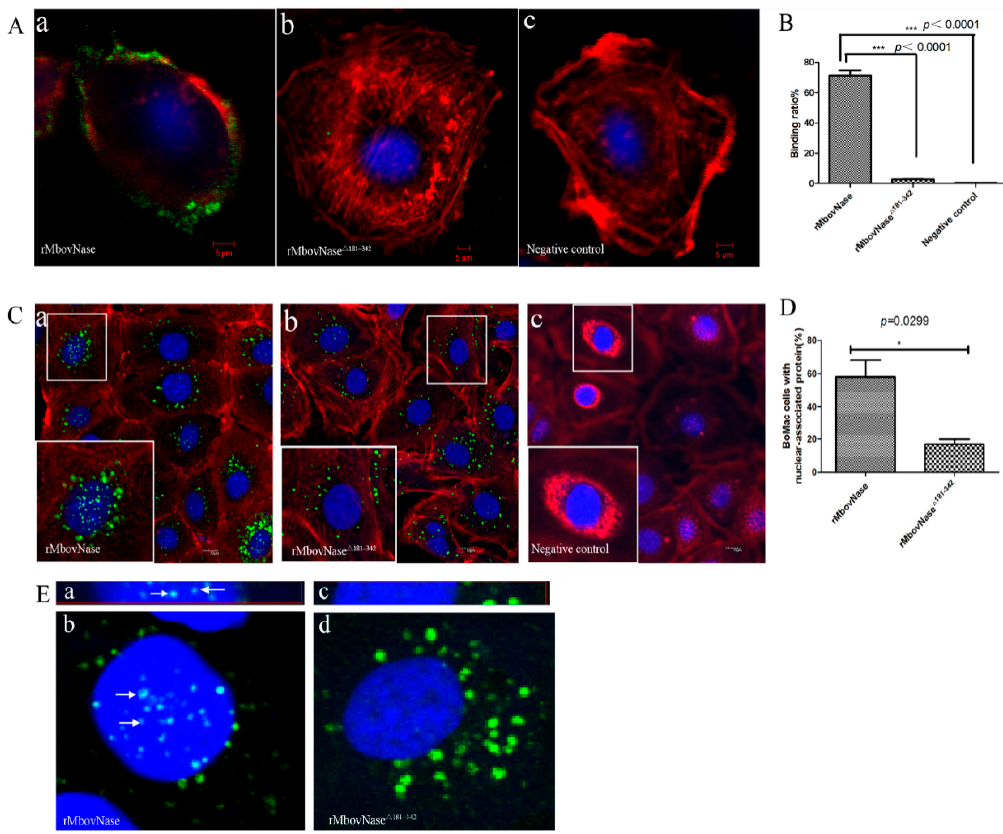
Figure 6. Assay of rMbovNase adhesion and invasion to BoMac cells. ( A ) Binding of rMbovNase and its variant to BoMac cells observed by confocal laser microscopy. BoMac cells were incubated with 10 μ g·mL − 1 rMbovNase ( a ) or rMbovNase Δ 181–342 ( b ) for 30 min at 4 °C. The attached protein was probed with mouse antiserum against rMbovNase (1:500) and then with goat anti-mouse IgG conjugated with FITC (green) Cellular actin filaments and nuclei were stained with rhodamine phalloidin (red) and DAPI (blue) respectively; magnifications: ×1000; ( B ) Binding assayed by flow cytometry. Standard deviations from the individual measurements are indicated as bars. *** p < 0.01; ( C ) Effect of TNASE_3 domain on invasion of rMbovNase ( a ) and rMbovNase Δ 181–342 ( b ). The method was the same as in the binding assay but incubated for 24 h at 37 °C. Laser confocal microscopy shows the deletion of TNASE_3 region in rMbovNase impaired its nuclear translocation but did not effect its internalization to cytoplasm. PBS treatment was negative control ( c ); magnifications: ×400; the zoomed images in the lower left boxes are ×3 magnifications of the images in middle small boxes; ( D ) Percentage of BoMac cells with nuclear-associated rMbovNase and rMbovNase Δ 181–342 immunofluorescence 24 h post-infection. Values are the means of 10 random microscopic fields and are representative of two independent experiments. Results were expressed as mean percentages ± SEM and were analyzed with the unpaired t -test. The difference between rMbovNase and its variant was statistically significant (* p = 0.029); ( E ) Localization of rMbovNase ( a , b ) in nuclei of BoMac cells shown by Z -series scanning. White arrows indicate the localization of rMbovNase within nuclear regions based on serially produced sections, while rMbovNase Δ 181–342 ( c , d ) only appeared in cytoplasm; magnifications: ×1000.